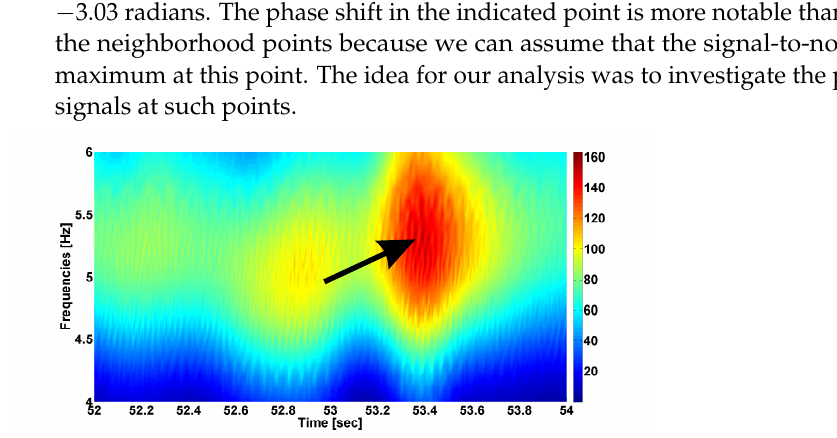
Figure 5. Example of the cross-wavelet spectrum of tremor signals in antagonist muscles in a first- stage PD patient. Signals from left arm with hyperkinetic movements are analyzed. The abscissa axis is time in seconds; the ordinate axis is frequency in Hz. Black arrow indicates the local maximum in the cross-wavelet spectrum.